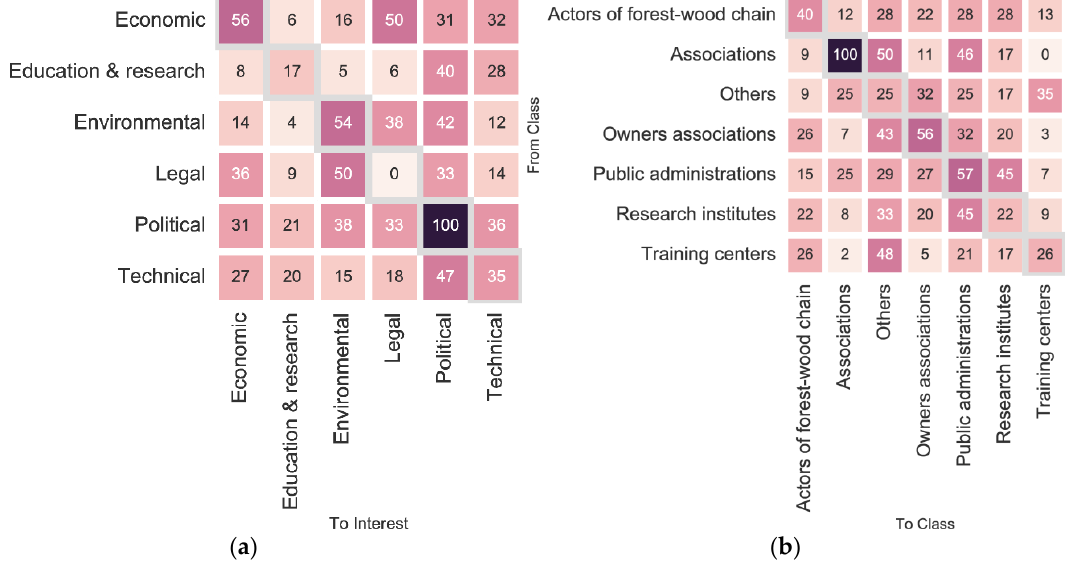
Figure 2. Connections between interests ( a ) and between classes ( b ) (in percentages).